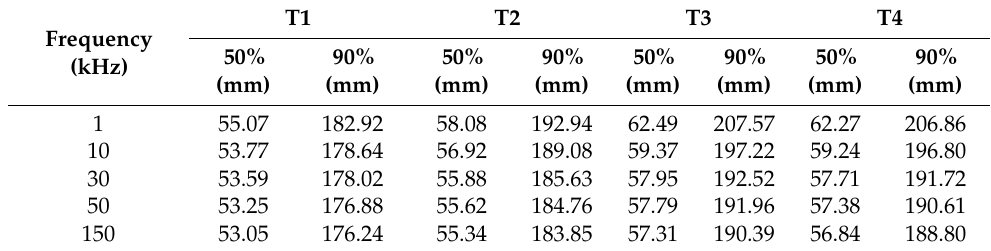
Table 6. AE signal energy attenuation